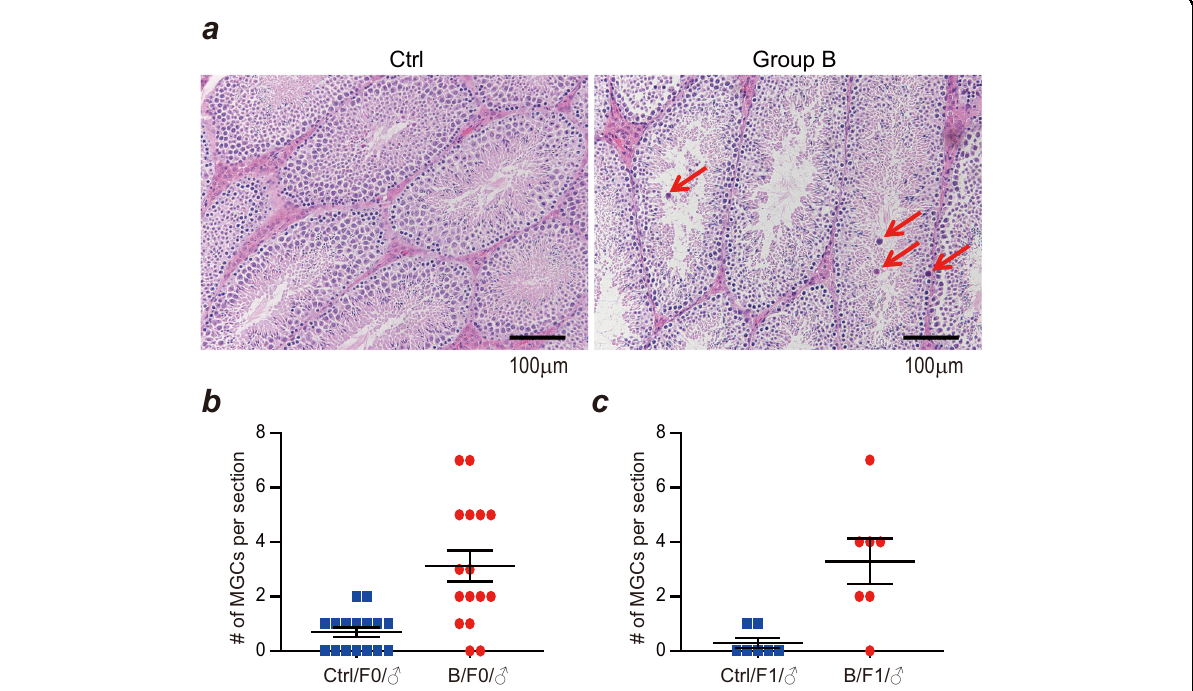
Fig. 6 IHC of testis from control male and group B male testes. a Tipic IHC on testes sections from two groups were shown here. The multinucleated giant cells (MGCs) were pointed out by red arrows. The scale bar is 100 μ m. b , c The number of MGCs per section were counted and the average number is signi fi cantly high in group B than that in control. The number in F0 males ( b ) and in F1 males ( c